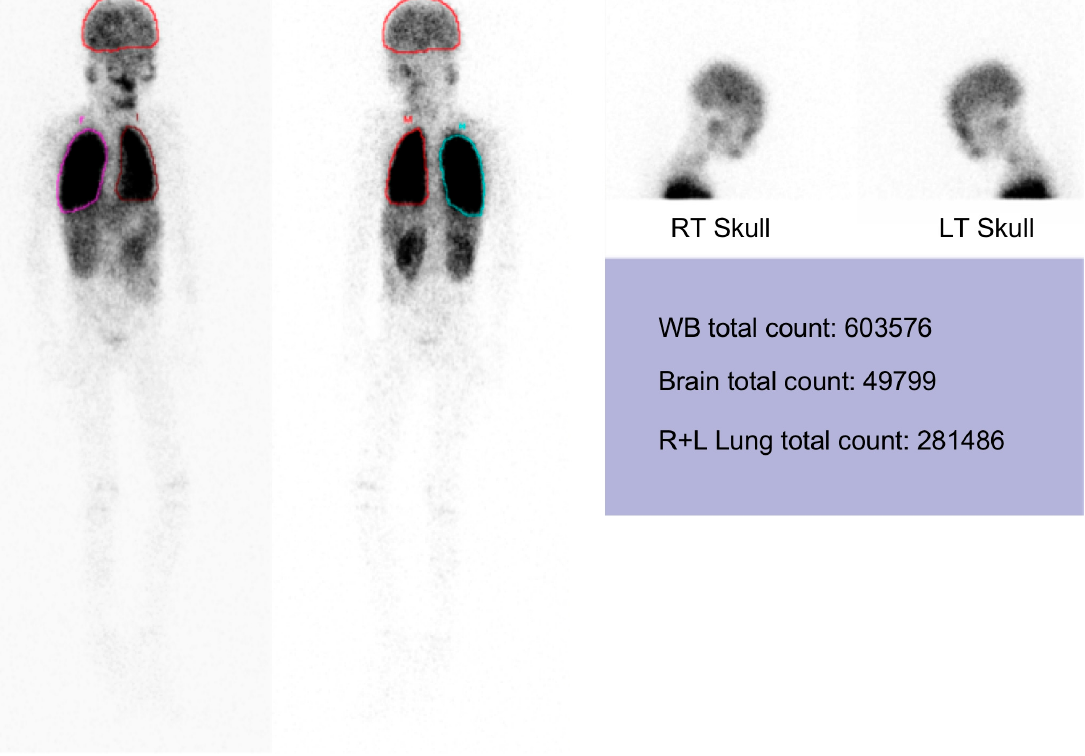
Figure 6. Technetium-99m-labeled macroaggregated albumin (Tc-99m MAA) dynamic perfusion imaging and total-body scans showing abnormal increased uptake in the brain immediately after Tc-99m MAA injection, with calculated intrapulmonary right-to-left shunts of 57.6%. LT, left; RT, right; R+L, right plus left; WB, whole body.